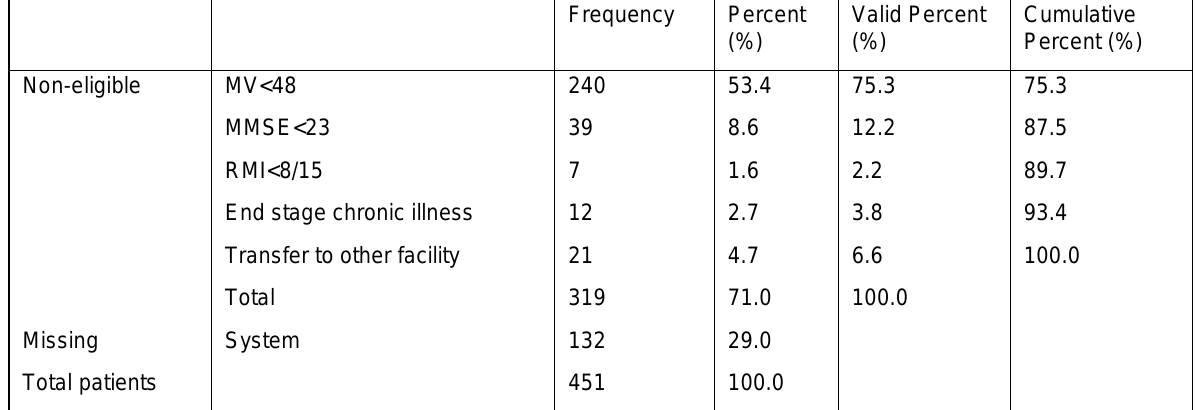
Table 3. Non-eligibility Frequency